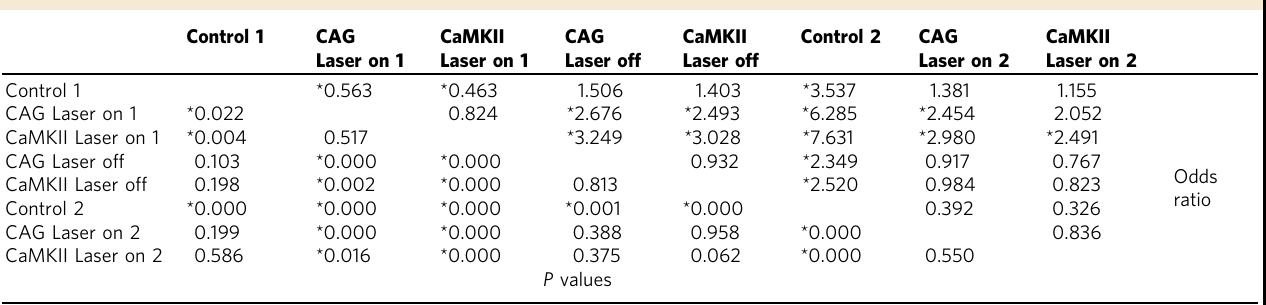
GLM via PQL (penalized Quasi-Likelihood procedure) was performed using the R function glmmPQL. Signi fi cant values are shown by asterisks ( P< 0.05). Control 1 and 2: control group data for the fi rst andsecond periodsof monaural occlusion,respectively;CAGand CaMKII:different promotersused intheArchT group.Laseron1: fi rst periodof monaural occlusionwiththe laseron;laser on2:second period of monaural occlusion with the laser